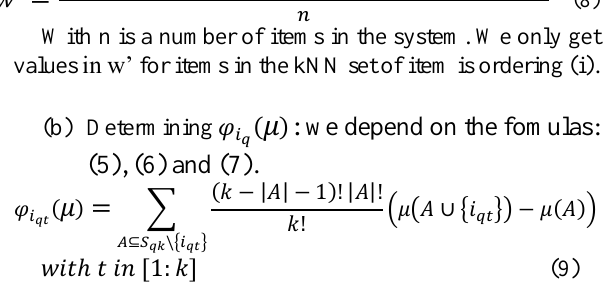
Table 3. Item important degree 𝜑 𝑖